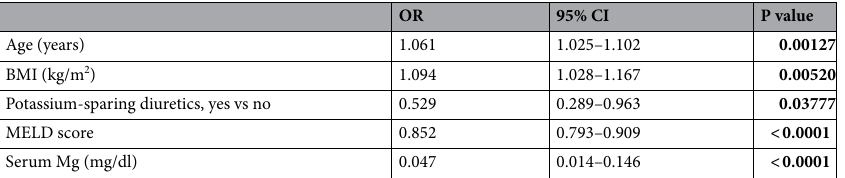
Table 2. Factors associated with the presence of HCC at stepwise multivariate binary logistic regression analysis. Model adjusted for cirrhosis etiology and gender. BMI body mass index, HCC hepatocellular carcinoma, MELD model for end-stage liver disease, Mg magnesium. p-values numbers marked in bold indicate numbers that are significant at the p < 0.05 level